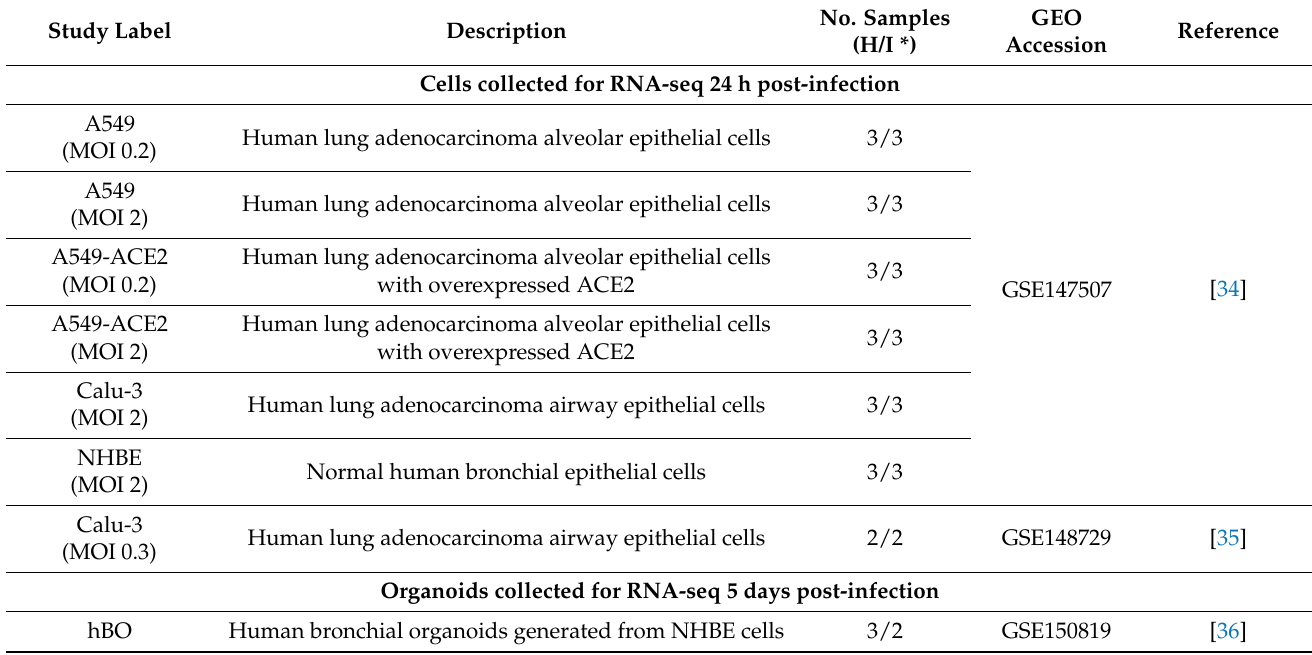
Table 1. Publicly available transcriptomic datasets used in the